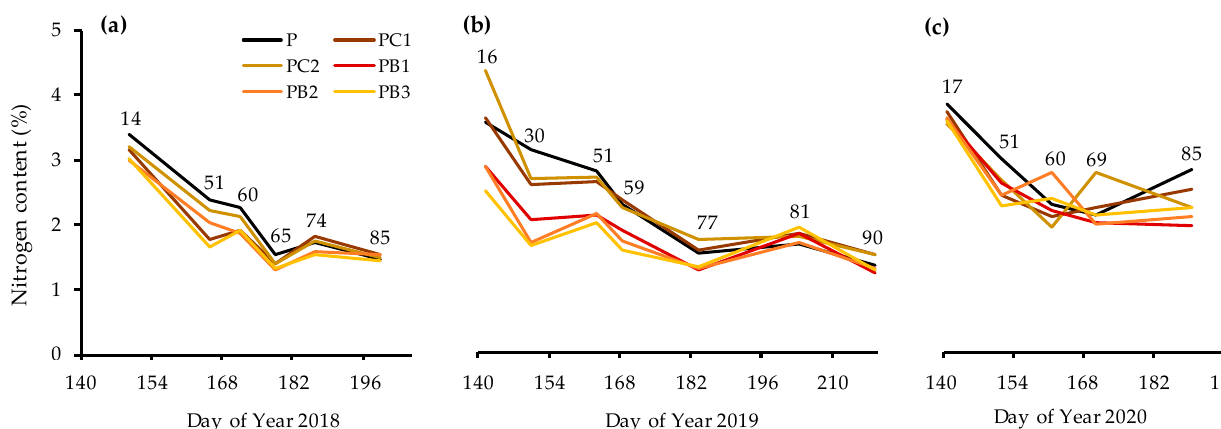
Figure 5. Nitrogen content of poppy plants from sole cropping (P), intercropped with barley at three different seeding densities (PB1, PB2, PB3) and intercropped with white clover at two different sowing times (PC1, PC2) in ( a ) 2018, ( b ) 2019 and ( c ) 2020. General principal growth stages (BBCH) as adapted for poppy are given in twodigit numbers at each sampling point. Detailed descriptive and inferential statistics can be found in Tables S8–S10.